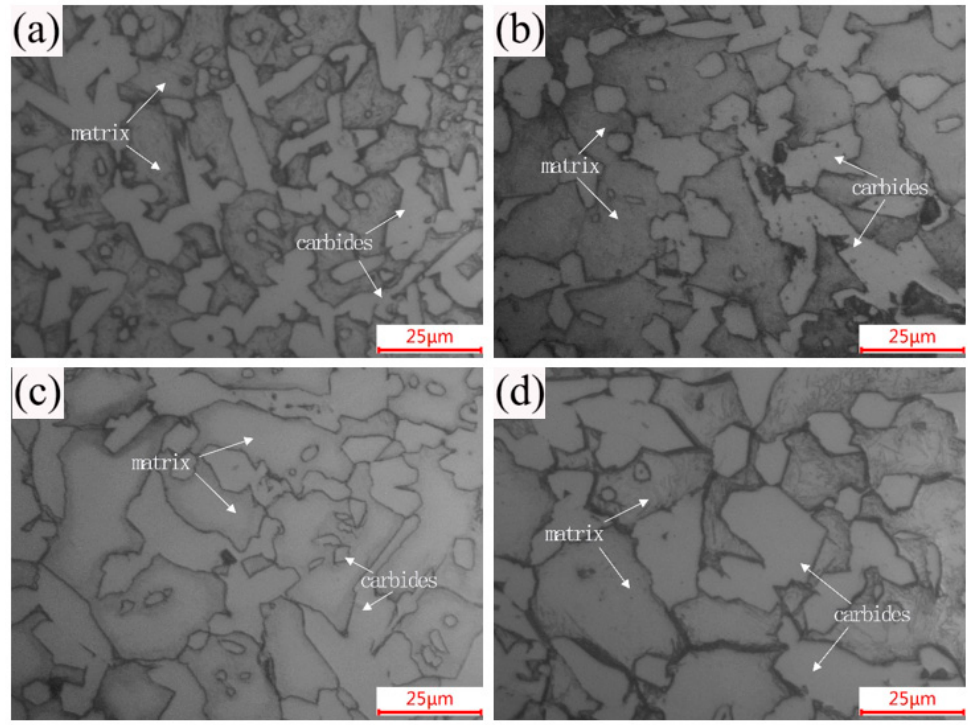
Figure 4. The microstructure evolution of fixed temperature SLPSed HCCI at ( a ) 1250 °C, ( b ) 1255 °C, ( c ) 1260 °C, ( d ) 1265 °C.